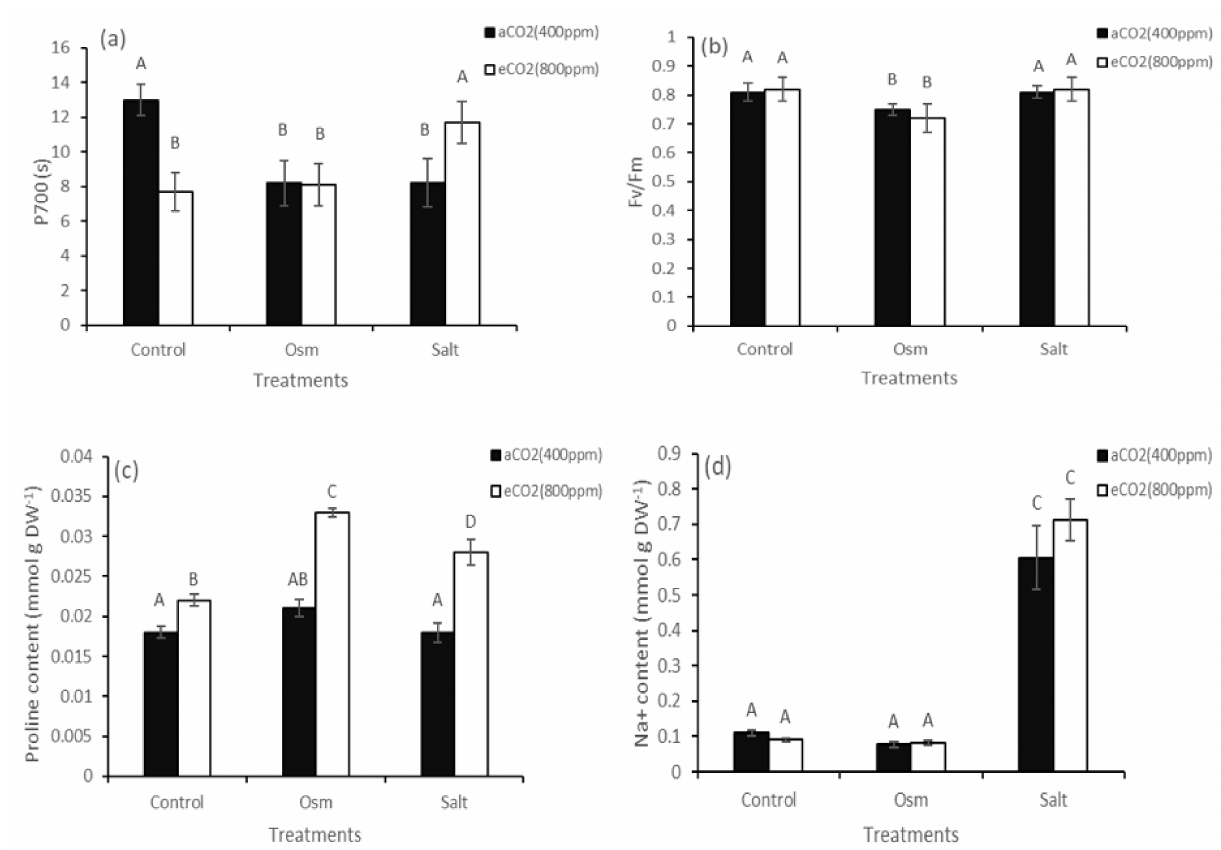
Figure 3. Time required to reach the maximum P700 oxidation level under far-red light (PSI) ( a ), maximum quantum yield of PSII reaction ( b ), content of free proline ( c ) and content of Na + ( d ) in plant leaves of C 4 Kochia prostrata at different CO 2 concentrations (400 and 800 ppm) under moderate ( − 0.6 MPa) PEG-induced osmotic stress (Osm) and salinity (Salt) similar in osmotic potential (200 mM NaCl). The values are means ( ± SE) of seven replicates. Different letters above the bars represent significant differences at the p < 0.05 (Tukey’s pairwise comparison). aCO 2 —ambient CO 2 concentration; eCO 2 —elevated CO 2